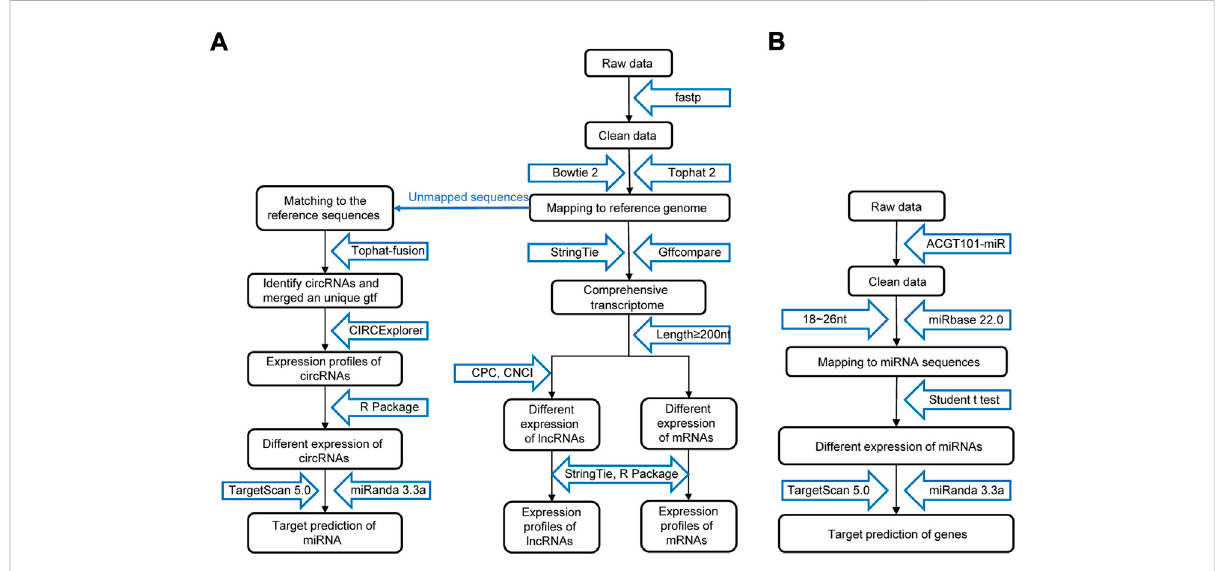
FIGURE 2 Procedure for preparing and analyzing an RNA library. (A) Process of preparing and analyzing circRNA, lncRNA, and mRNA libraries. (B) Process of preparing and analyzing miRNA libraries. CPC, coding potential calculator; CNCI, coding-noncoding